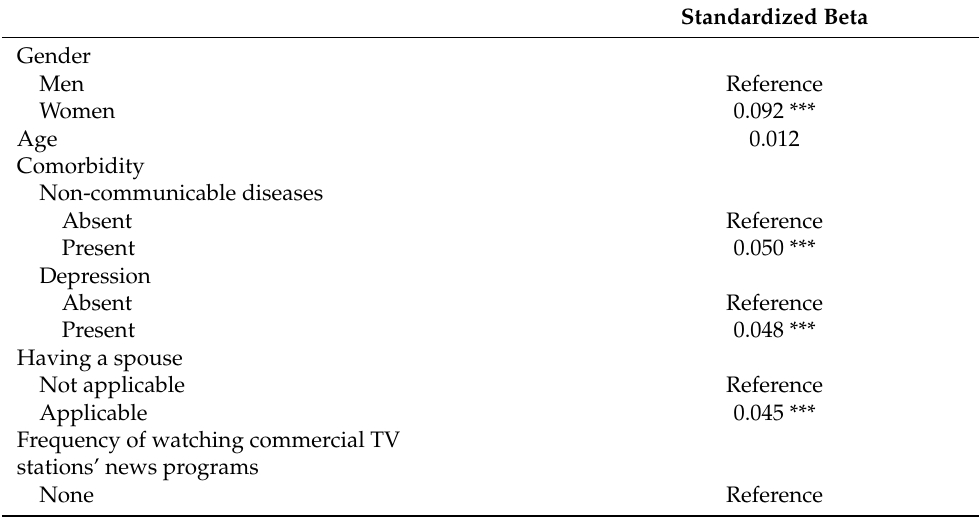
Table 3. Standardized betas for Fear of COVID-19 Scale scores: multiple linear regression